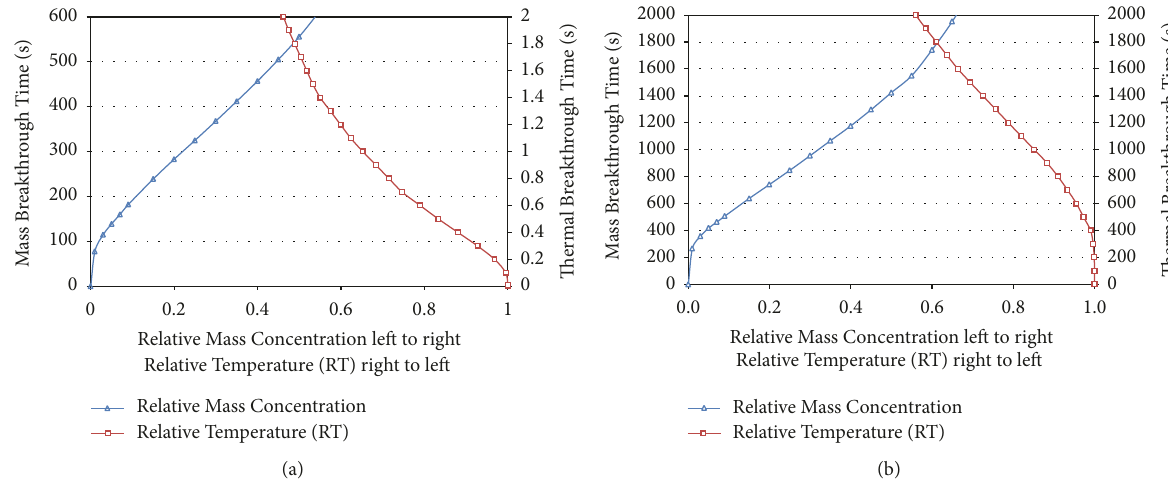
Figure 10: Relative Concentration (RC) of the mass and Relative Temperature (RT) of the fluid at the outlet as a function of time: model with the length scale of 1mm (a) and model with the length scale of 100 mm